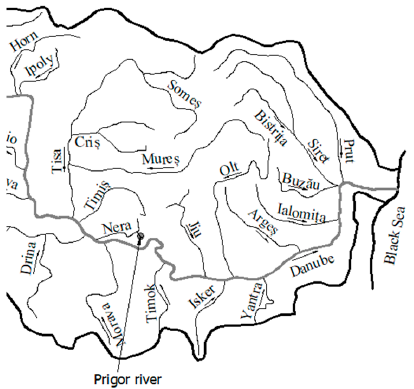
Figure 4. The Prigor River location—Prigor hydrometric station.